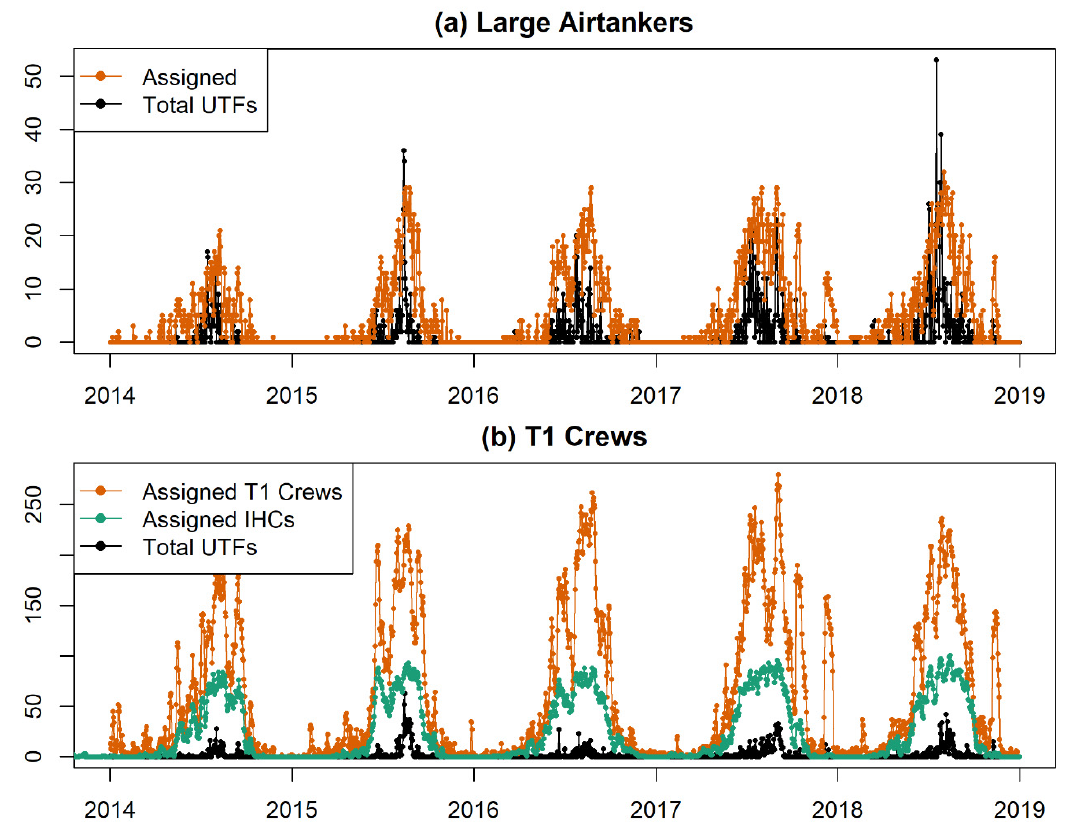
Figure 5. Two daily metrics of resource use and scarcity for large airtankers ( a ) and Type 1 crews ( b ). The orange line indicates the number of such resources assigned each day as recorded in ROSS. The black line indicates the number of requests returned Unable to Fill (UTF) as recorded in ROSS. The data summary utilizes all requests within the United States.